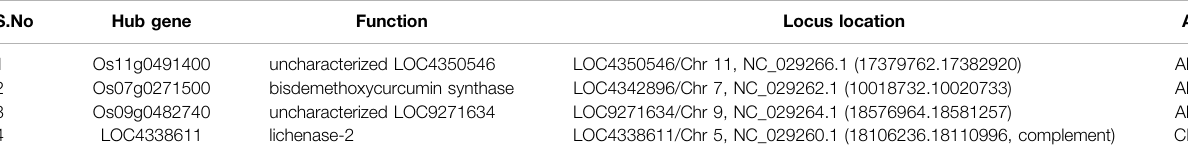
TABLE 7 | Identi fi ed hub genes with respect to their level of connectivity in the black module. S.No